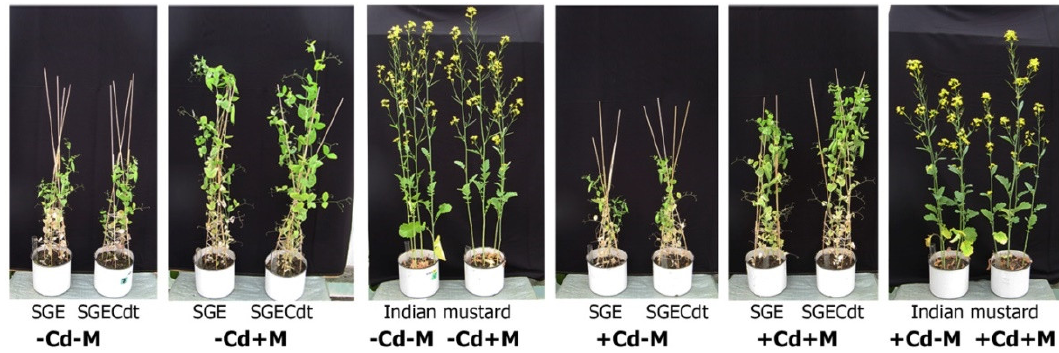
Figure 2. Representative plants of SGE, SGECd t , and Indian mustard ( B. juncea ) photographed on the 42nd day after planting. Treatments: -Cd-M—uncontaminated soil with uninoculated plants, -Cd + M—uncontaminated soil with inoculated plants, + Cd-M—Cd-supplemented soil with uninoculated plants, + Cd + M—Cd-supplemented soil with inoculated plants. Plants were inoculated with a microbial consortium consisting of Variovorax paradoxus 5C-2, Rhizobium leguminosarum bv. viciae RCAM1066, and Glomus sp. 1Fo.